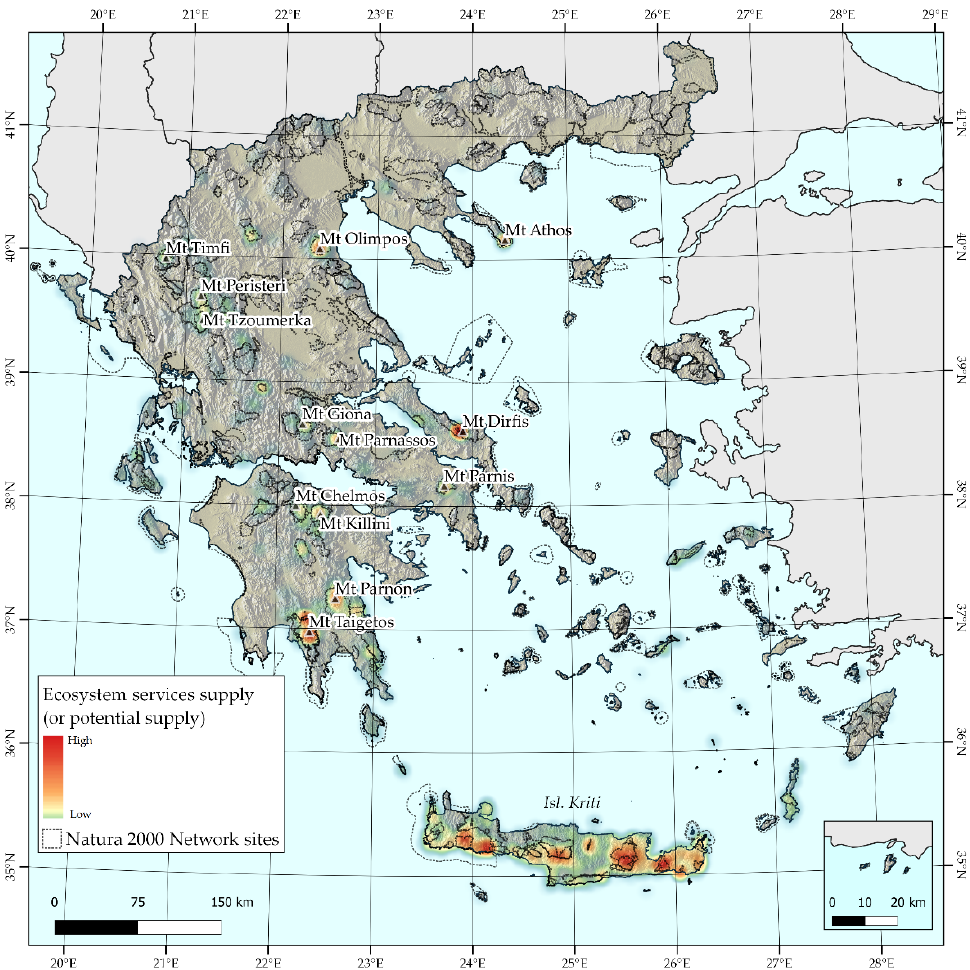
Figure 6. Ecosystem services hotspots in Greece, based on the recordings of the Greek endemic Lamiaceae. Natura 2000 sites in Greece are also depicted. 141